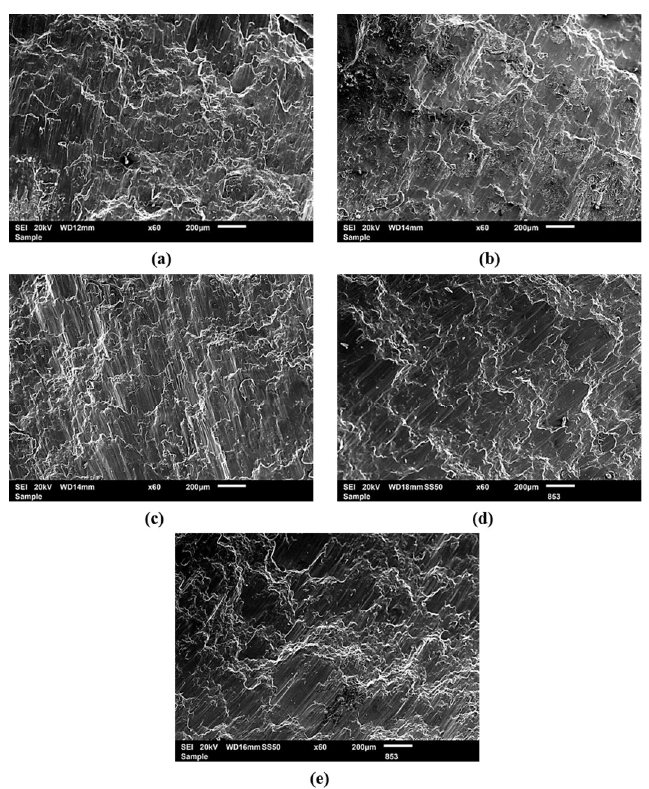
Figure 6. Compression fractography of ( a ) Pure Mg, ( b ) Mg0.5NiTi, ( c ) Mg1NiTi, ( d ) Mg1.5NiTi and ( e ) Mg3NiTi nanocomposites.